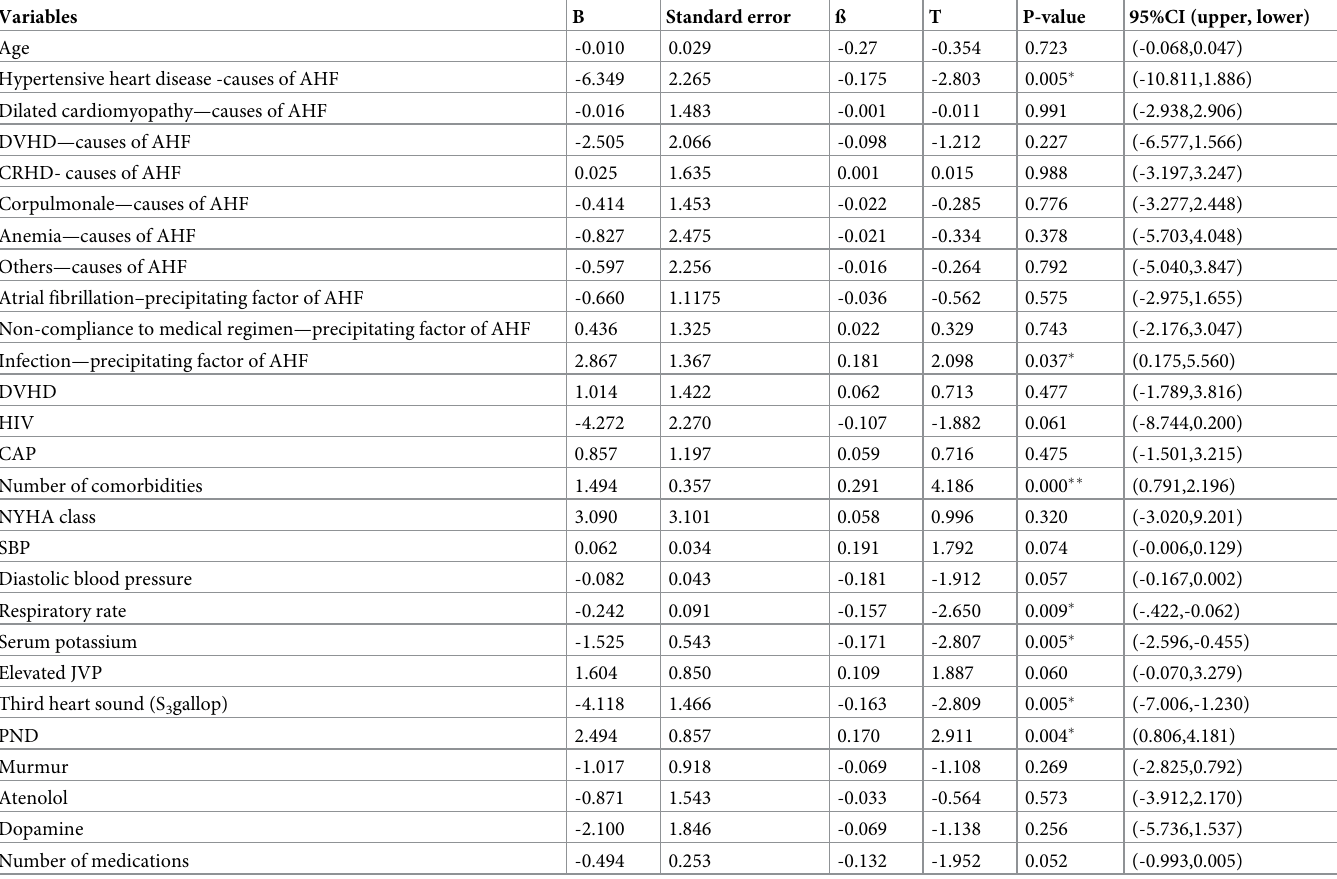
Table 3. Multiple linear regression for LOS of AHF patients admitted at UOGCSH medical